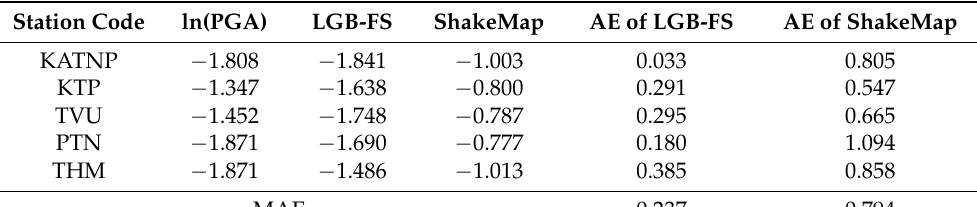
Table 4. Performance comparison of the LGB-FS for PGA prediction with ShakeMap after Nepal earthquake.